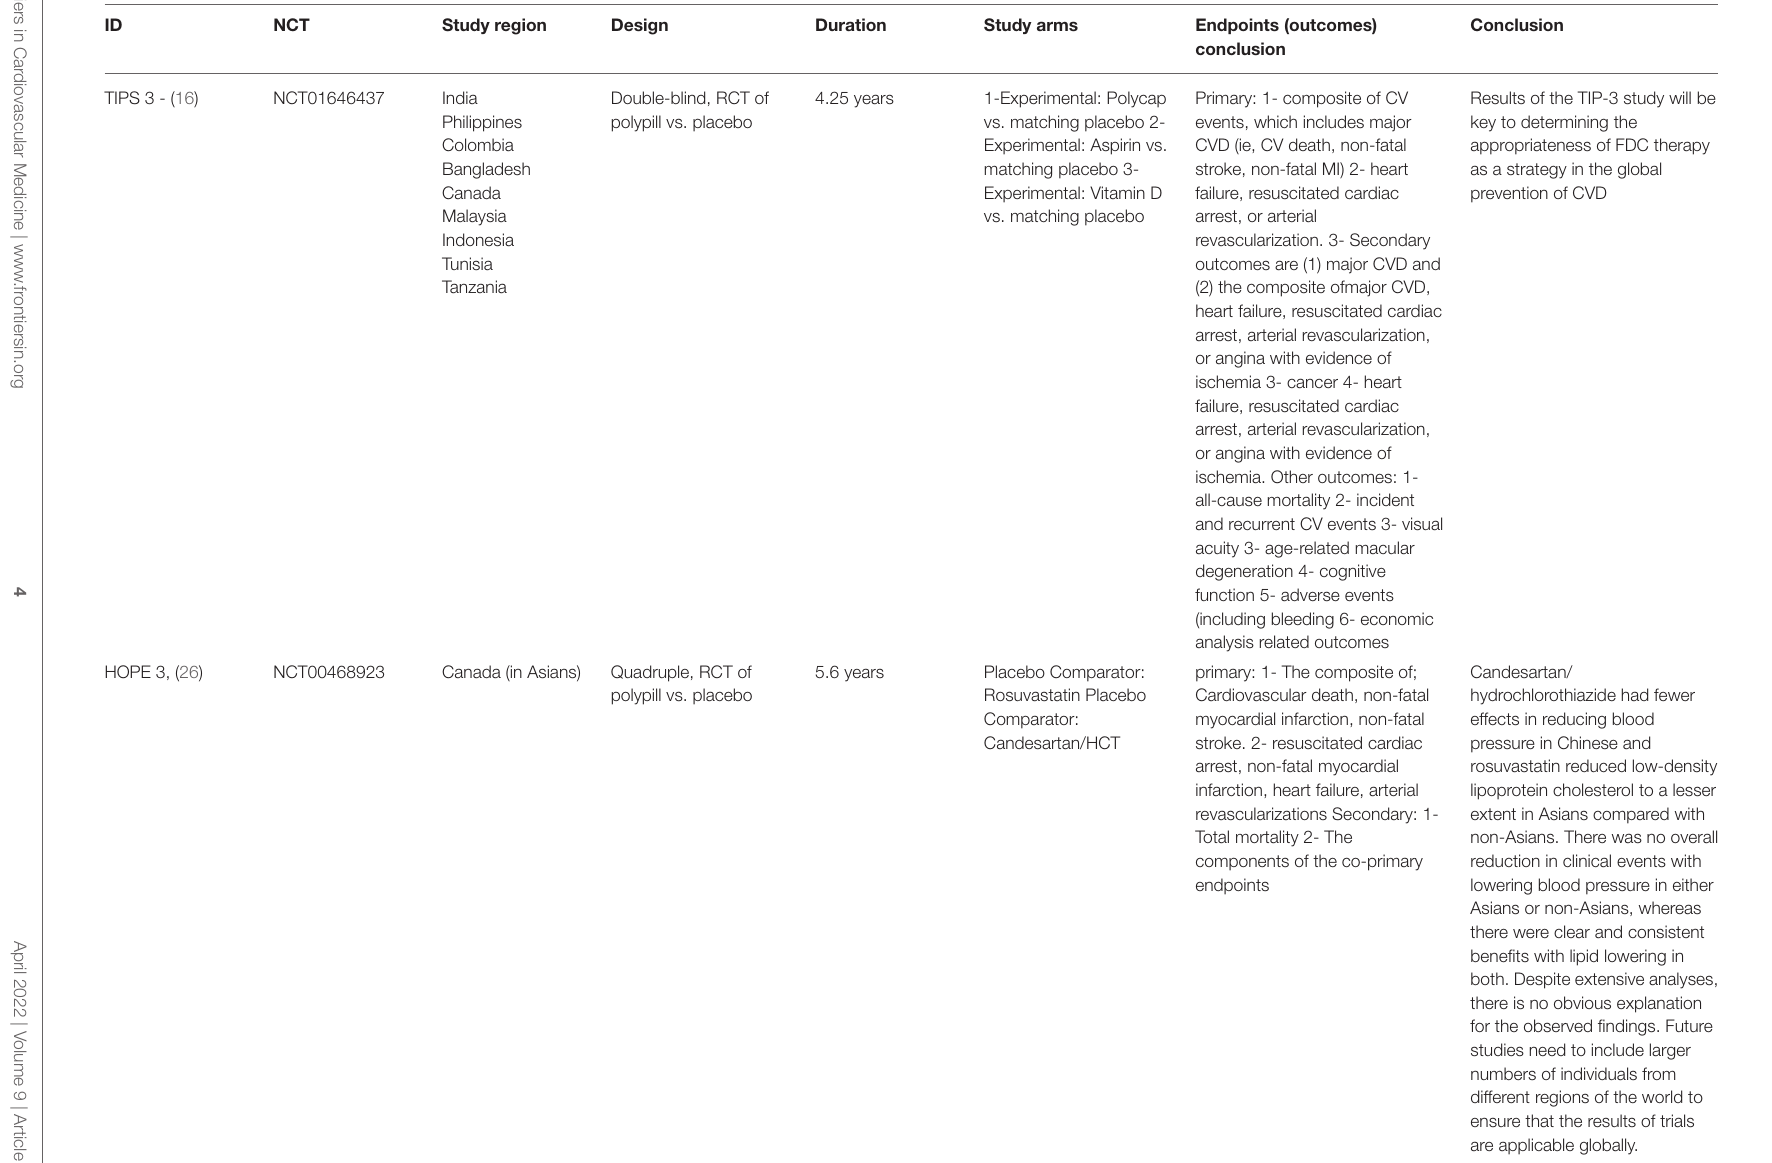
TABLE 1 | Summary of the included studies (13–21).